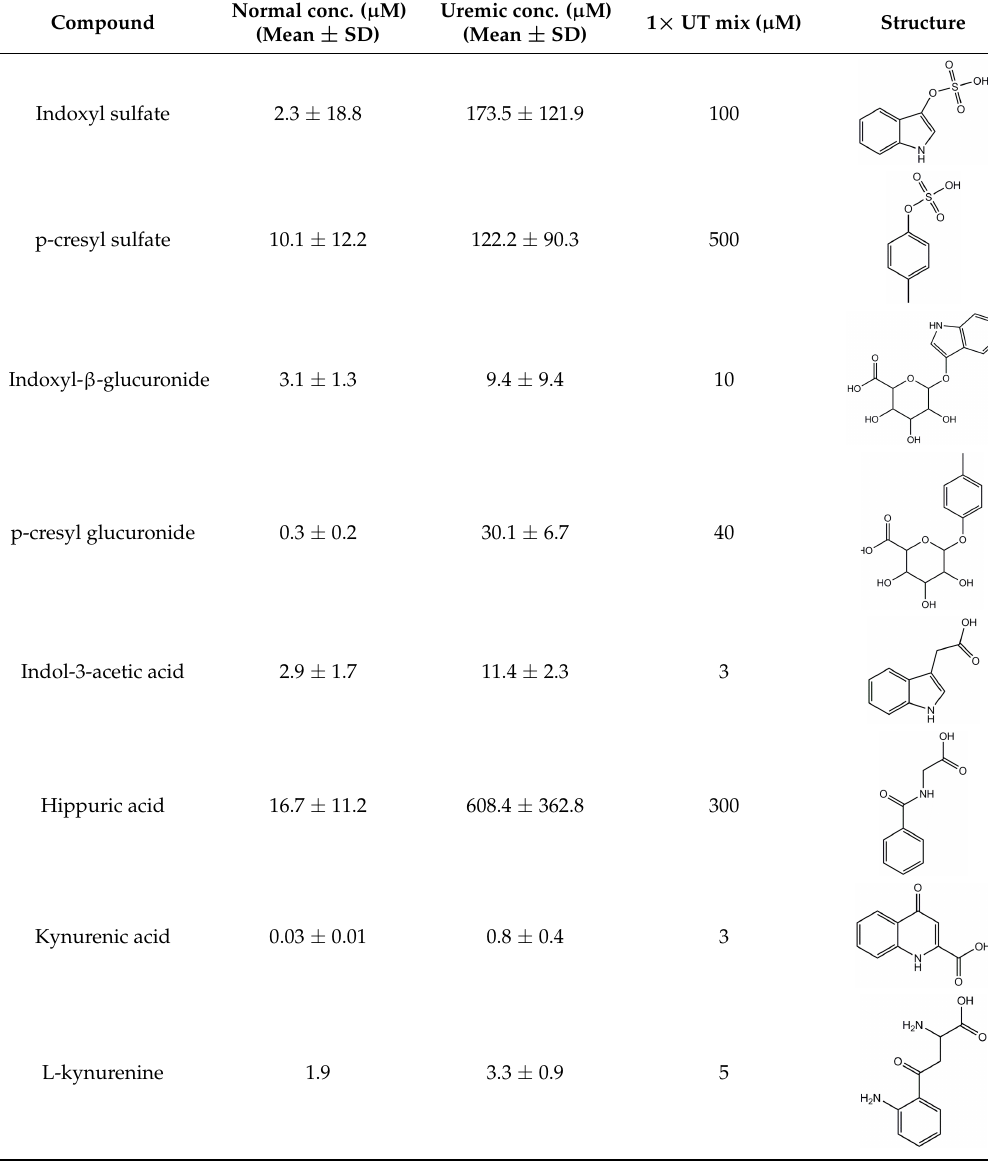
Table 1. Concentrations of anionic uremic toxins in healthy individuals, uremic patients, and as applied in the present study. Concentrations used are adapted from EUToX Uremic Solutes Database (http://uremic-toxins.org/DataBase.html) and Jansen et al. [33]. Normal conc. Compound